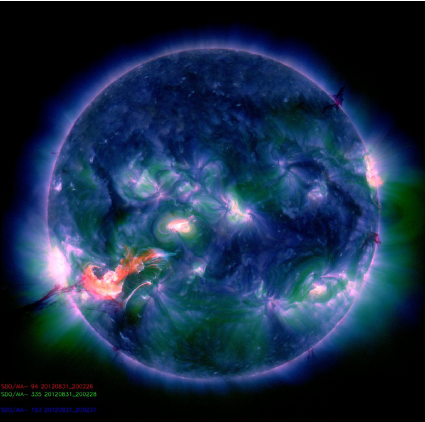
Figure 1. AIA composite of EUV emissions (94, 193, and 335 Å) (ref.: http://sdo.gsfc.nasa.gov).